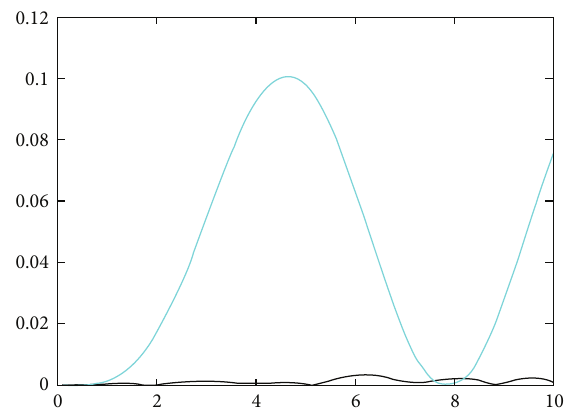
Figure 13: Error in the symbolic (black) and numeric (blue)